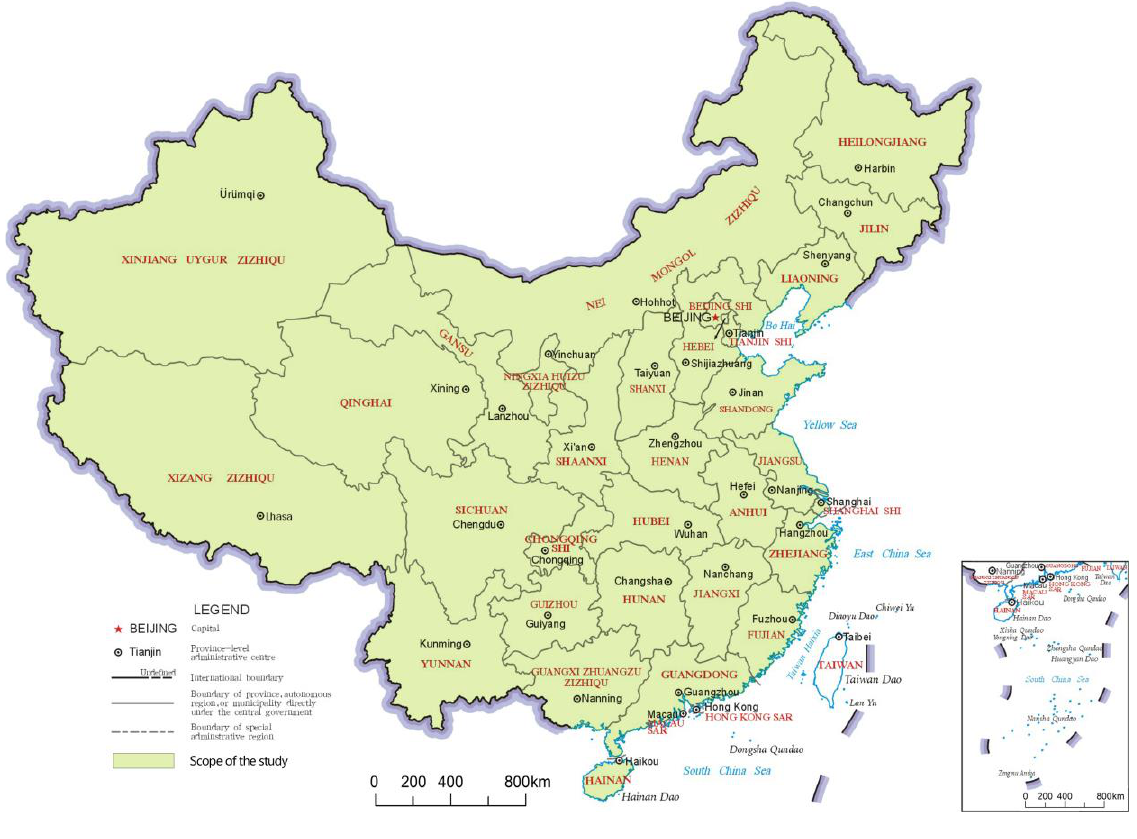
Figure 1. Scope of the